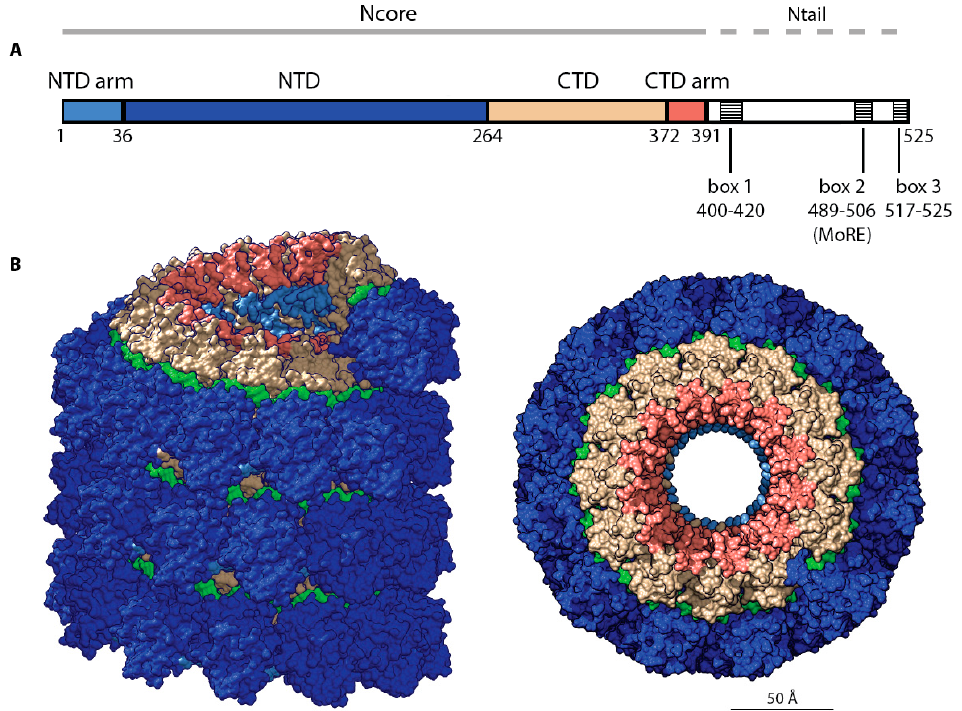
Figure 2. Cont Figure 2.